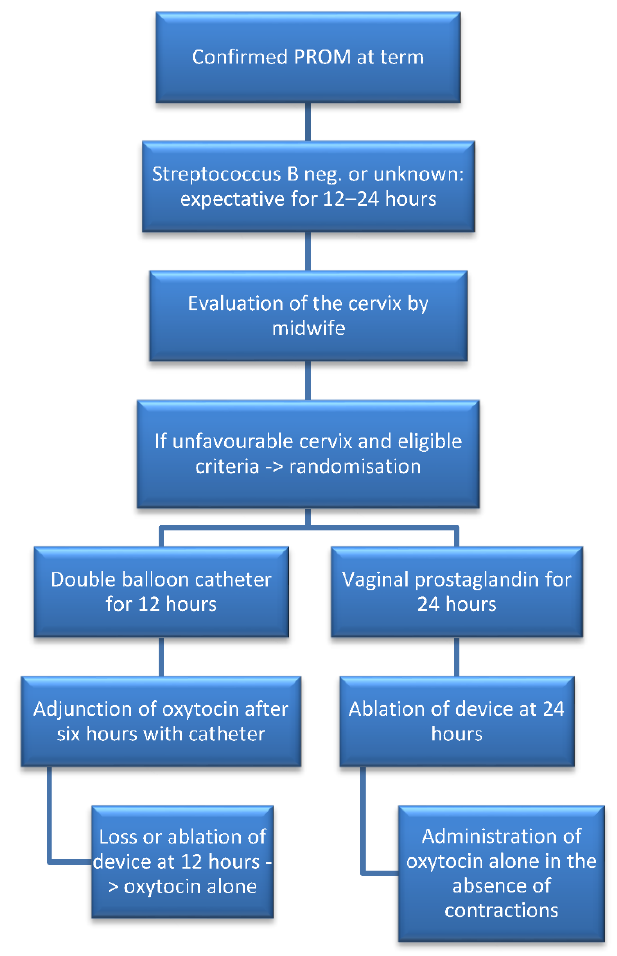
Figure 1. Flowchart describing the main stages of the study. Outcome data were either documented on an ongoing basis by the labor and delivery team, or obtained from medical records by research personnel not involved with data analysis. The primary outcome was the period of time between induction (time of induction device insertion) and delivery (time of birth). Secondary outcomes included time between PROM and the start of induction, delivery rate within the first 24 h, duration of induction device placement, spontaneous or assisted vaginal delivery rate, rate of caesarean section and indications, postpartum hemorrhage rate (blood loss > 500 mL), Bishop score or measure of dilatation on catheter loss or removal, rate of balloon expulsion within 12 h of placement, rate of oxytocin cessation, balloon or vaginal dinoprostone insert removal due to suboptimal FHR, epidural analgesia rate, time taken to achieve active labor and full dilatation, pain levels assessed using the Visual Analog Scale of Pain Intensity (VASPI) at time of placement, every 6 h and after removal, uterine hyperstimulation rate, fever during labor rate, rate of clinical chorioamnionitis(defined as fever and combination of fetal tachycardia, or uterine contraction, or purulent fluid from the cervical os, or abdominal pain), rate of materno-fetal infection, endometritis, histological chorioamnionitis, and positive bacteriological culture. Neonatal outcomes included birth weight, lactates, rate of Apgar score <7 at 5 min, umbilical artery pH < 7.15, and neonatal intensive care unit admission. 2.3. Statistical Analysis and Sample Size Calculations